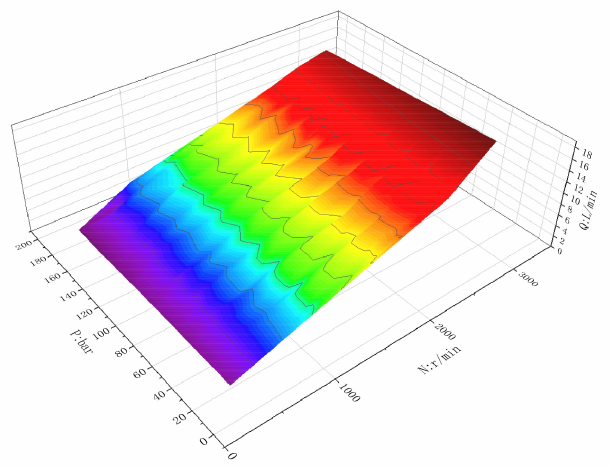
Figure 16. Experimental diagram of pump flow envelope